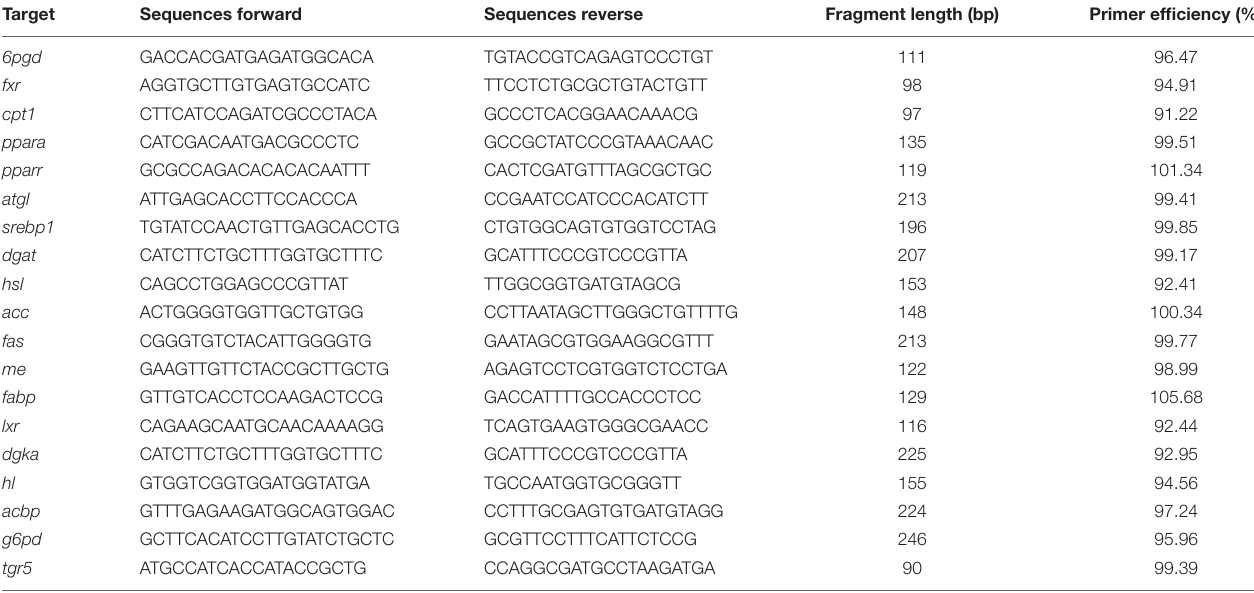
TABLE 1 | Primers designed for